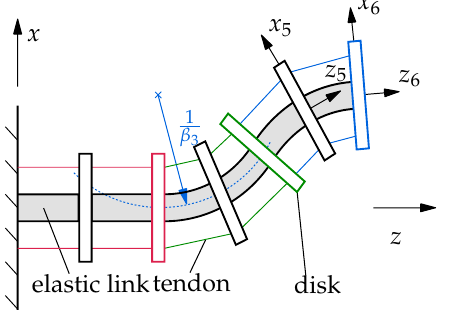
Figure 2. Schematic representation of the 2D system with 6 segments described as the PCC model.